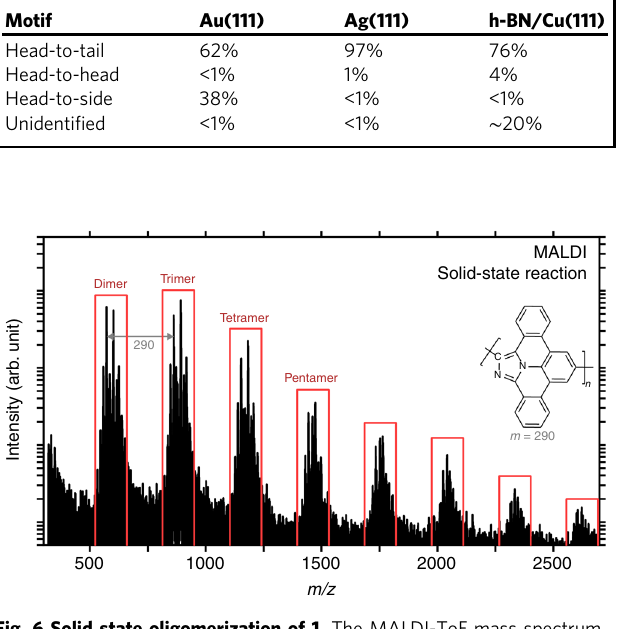
Fig. 6 Solid state oligomerization of 1. The MALDI-ToF mass spectrum after thermal annealing of 1 to 520 K for 72 h under vacuum (10 − 2 to 10 − 1 mbar) shows distinct peak groups indicative of intermolecular coupling upon formation of oligomers (dimers, trimers, tetramers, etc.). The separation of 290 m/z between these peak groups corresponds to the mass of one monomer unit (C 21 N 2 H 10 , chemical structure in the